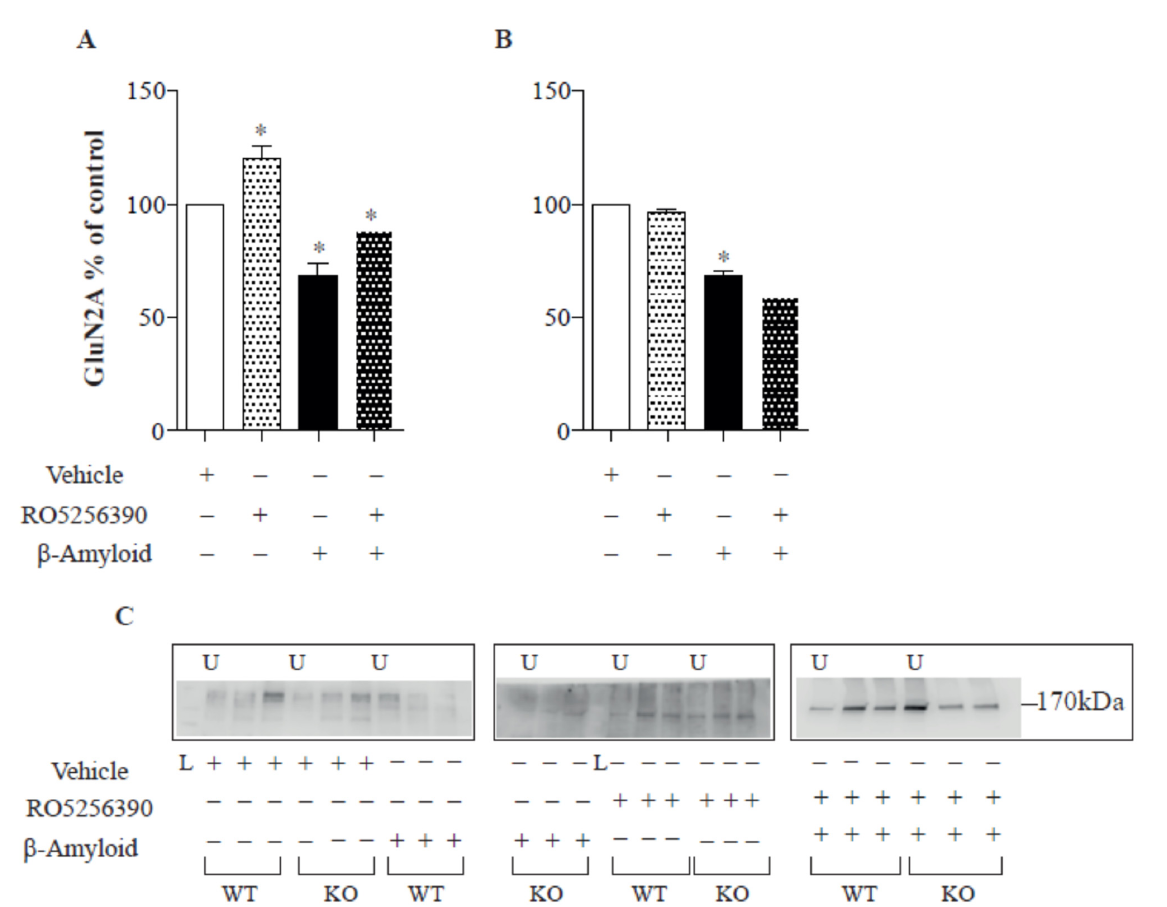
Figure 2. Effect of A β and RO5256390 on GluN2A receptors in vitro. A β application in cell medium reduces GluN2A surface expression, while TAAR1 activation (induced by RO5256390 agonism) is able to counteract A β effects in control cells ( A ) but not in KO cell cultures ( B ). ( C ) Examples of Western blot images: U = unbound, L = ladder. Results are representative of six different cell cultures (* p < 0.05).